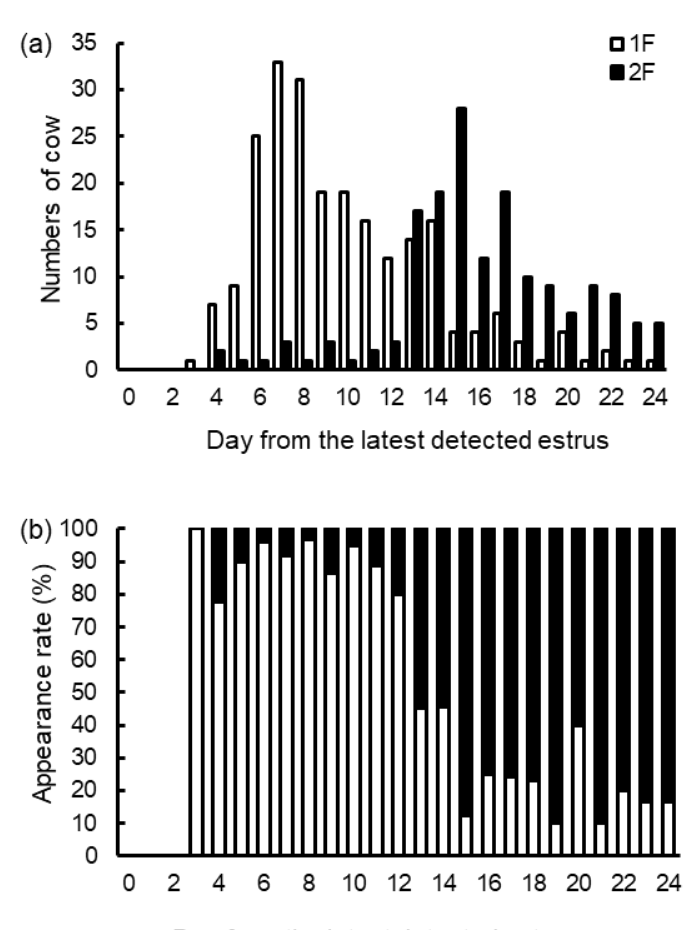
Figure 3. Distributions of numbers and appearance rates of 1F and 2F after the latest detected estrus. The distribution day of the number of cows for each of 1F and 2F is shown in ( a ). The distribution day of the respective appearance rates of 1F and 2F within each day is shown in ( b ). Here, 1F = cows with one large follicle at the ovarian examination, n = 229; 2F = cows with two or more large follicles at the ovarian examination, n = 164. The day of the latest detected estrus is defined as 0 d. Ovarian examination was conducted once a week, every Saturday, in each